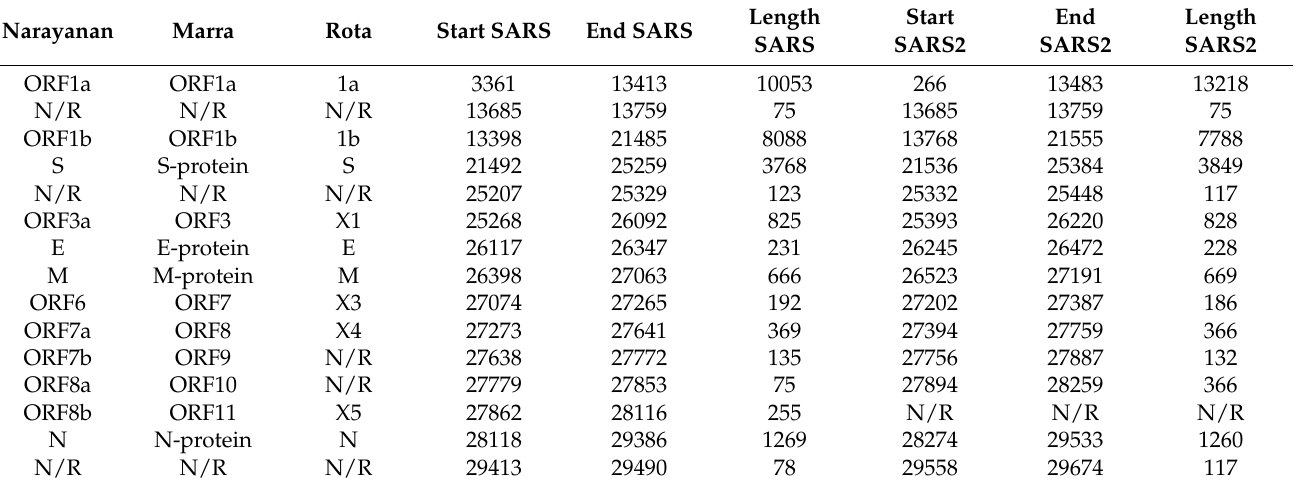
Table 1. SARS-CoV-2 and SARS-CoV genome organization data. The ORF names defined in different papers are